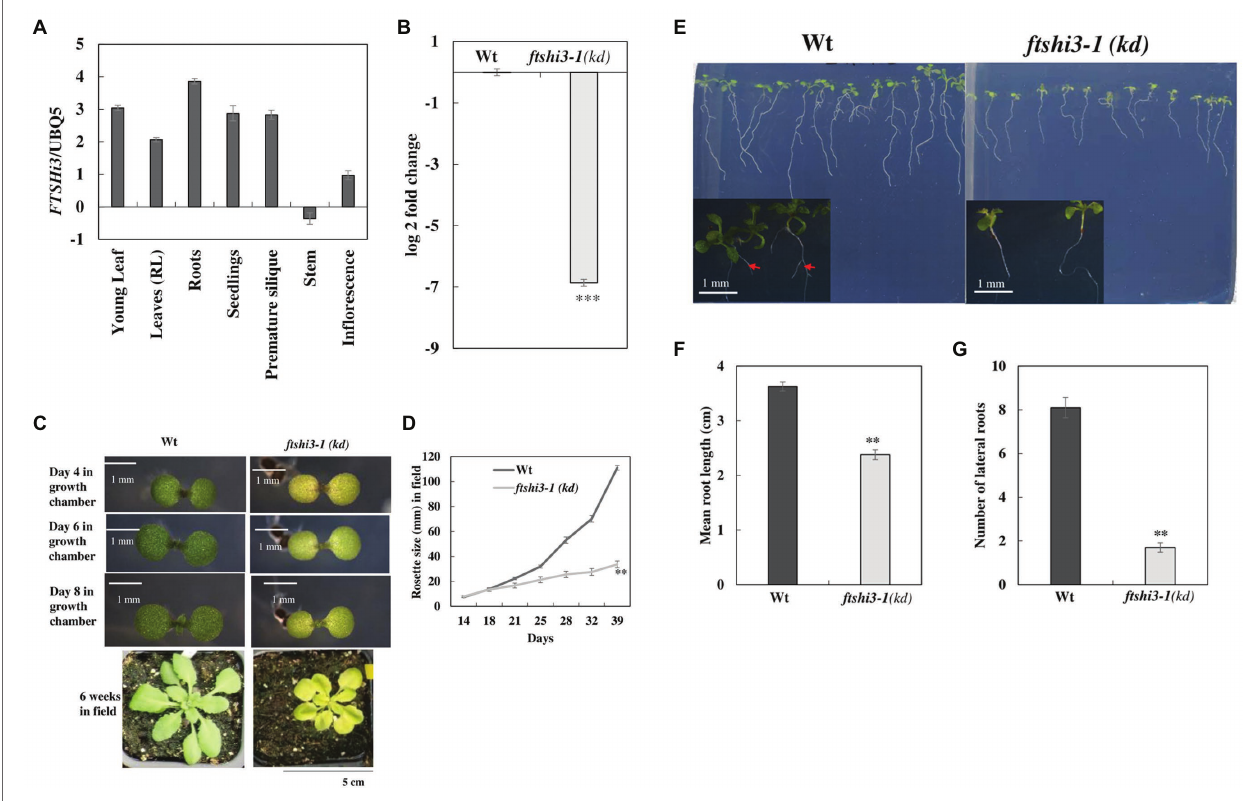
FIGURE 1 | (A) Graphical representation of the organ-specific relative expression of AtFTSHi3 (dCT values normalized to At-UBQ ). (B) Log 2-fold change of AtFTSHi3 transcript abundance in 4-week-old rosette leaves of Wt and ftshi3-1(kd) . The data are normalized to the expression of genes coding for At-UBQ and At-Tubulin . An asterisk indicates significant differences between Wt and the ftshi3-1 (kd) seedlings ( ** p < 0.05, Student’s t test, n = 3); error bars represent the SE. (C) Phenotypes of 4-, 6-, and 8-day-old seedlings of Wt and ftshi3-1(kd) grown in a growth chamber under short-day (SD) at 22 ° C (scale bars are 1 mm), or for 6 weeks under field conditions (Scale bar 5 cm). (D) Rosette diameter measurements were performed from 2 to 6 weeks on field-grown plants. Asterisks indicate a significant difference ( ** p < 0.05, Student’s t test, n = 8). (E) Root phenotype of 8-day-old seedlings from Wt and ftshi3-1(kd) . Arrows indicate the lateral roots. (F,G) Graphical representation of the root length (F) and the number of lateral roots (G; ** p < 0.05, Student’s t test, n >